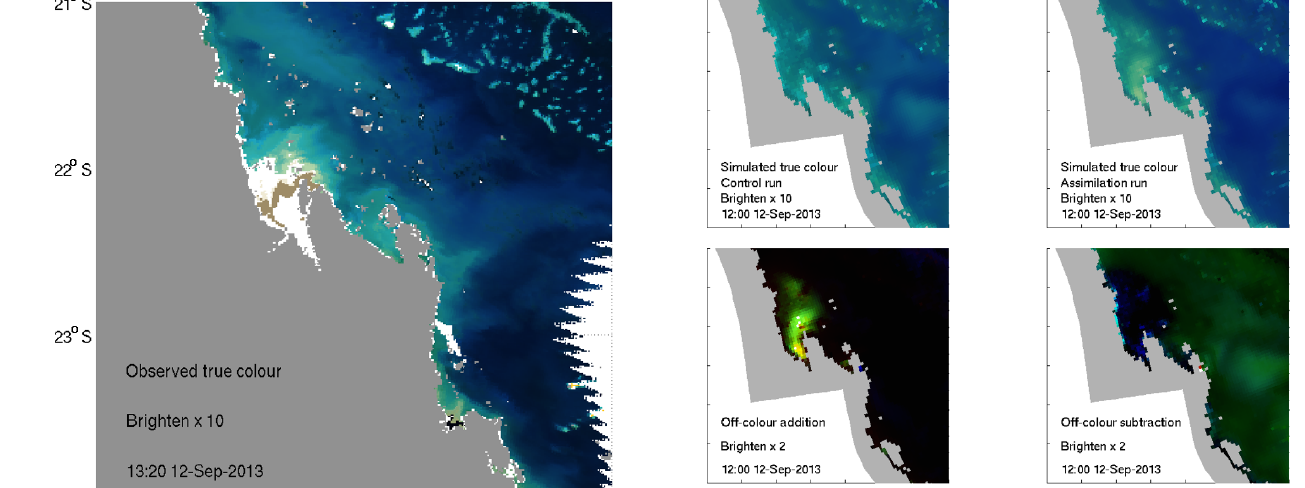
Figure 17. The simulated true-colour image on 12 September 2013 of the control run (top left) and EXP4 assimilation run (top right). The difference between the remote-sensing reflectance in the con- trol and assimilated runs was used to quantify the colour (referred to as off-colour) added (i.e. greater surface expression, bottom left) and subtracted (i.e. less surface expression, bottom right) due to the updating of optically active constituents in the assimilation run (see Fig. 16 for more details). Note that the off-colour images have a smaller brightening factor as the MODIS true-colour stretch satu- rates the features that are of most interest. Simulated true-colour images are not falsely coloured, and thus do not require a colour map, nor are they 2-D as they have a depth of field, being based on reflectance from multiple depths and the bottom (Baird et al., 2016a). Thus simulated true colour can be considered a photograph of the optical state of the different model runs and, like observed true colour, a powerful and intuitive visualisation tool for water clar- ity in BGC